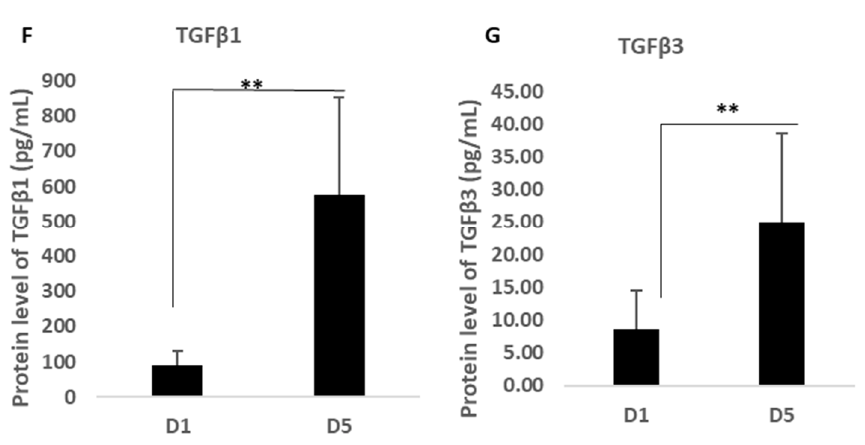
Figure 4. Cytokines and growth factors in the MFAT condition medium in a serum free culture for one day and five days. ( A ) ; shows an example of a heat map of 32 factors after a serum free culture of MFAT (carried out on 7/8 of the donors). With multiplex analysis, 50 µL of the MFAT serum free culture condition medium was detected for 32 cytokines and growth factors. Other heat maps and raw data are shown in Supplementary Tables S1 and S2. ( B ); There was a significant increase in IL-1Ra between one day and five-day culturing in serum free MEM α ( p < 0.05 *). ( C ); There was a significant increase in CXCL9 between one day and five-day culturing in serum free MEM α ( p < 0.05 *). ( D ); The expression of HGF was found but this remained stable between one day and five-day culturing ( p > 0.05 *). ( E ); MIF indicated significantly higher in five-day culturing than in one day cultures ( p < 0.05). ( F–G ); TGF β 1-3 secretion significantly increased in the MFAT serum free culture condition medium on day five (<0.01 **). Similarly, TGF β 3 secretion significantly increased in the MFAT serum free culture condition medium on day five as well (<0.01 **).